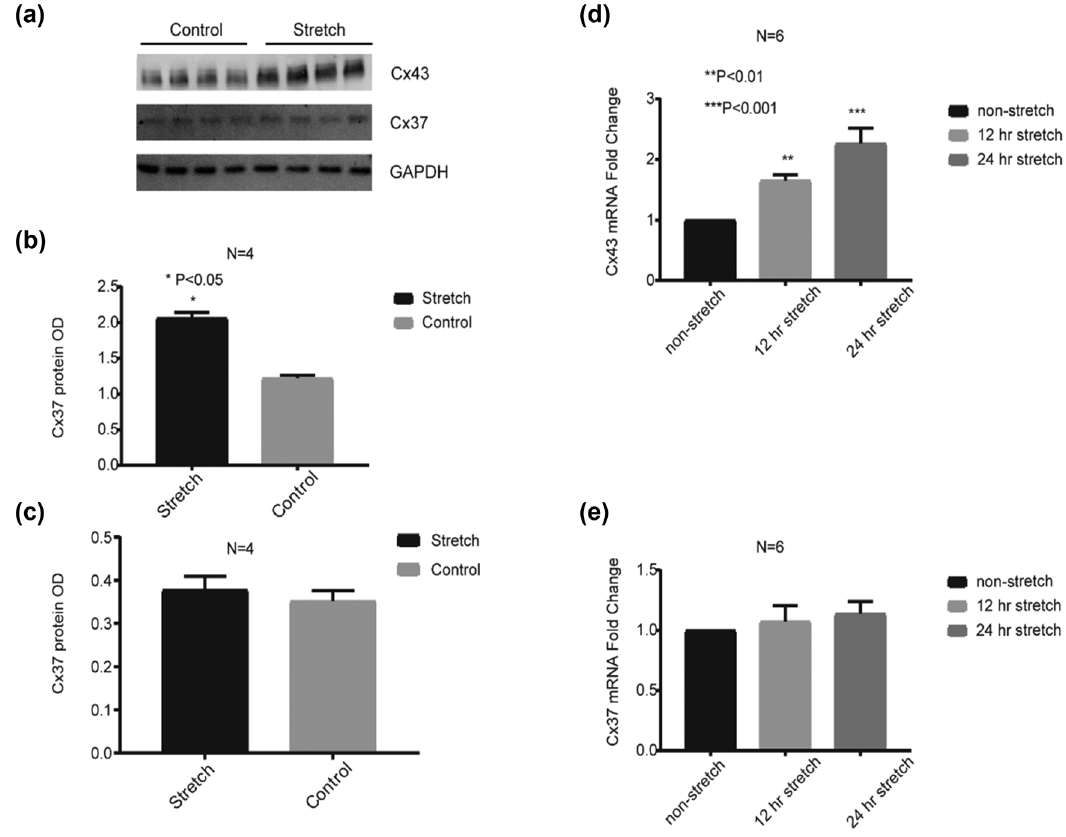
Figure 2: Increased Cx43 protein and mRNA expression in HUVECs after stretch. ( a – c ) The relative protein levels of Cx43 and Cx37 in HUVECs under 24 h stretch. ( d and e ) The relative mRNA expression of Cx43 and Cx37 in HUVECs under 12 and 24 h stretch. * P < 0.05, ** P < 0.01, and *** P < 0.001 vs the control or the